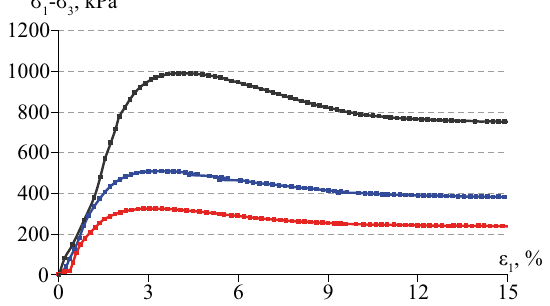
Fig. 10. Stress-strain ε 1 = ƒ(σ 1 – σ 3 ) curves (loose sand, H/D = 1): – 50 kPa; – 100 kPa; – 200